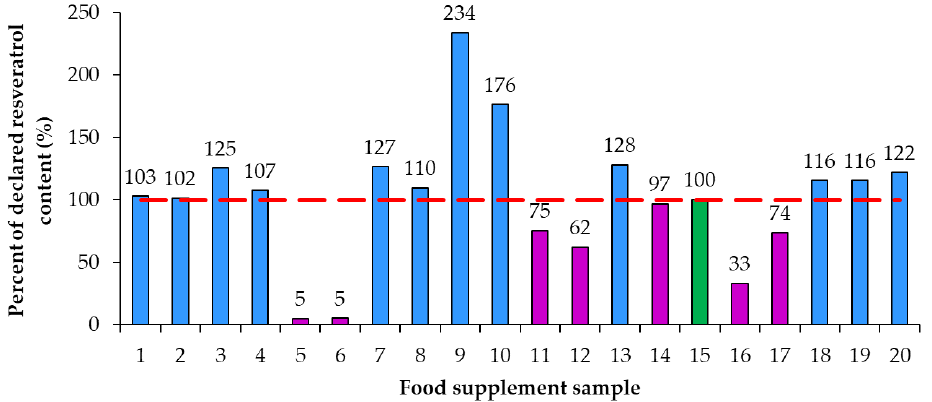
Figure 5. Percent of declared resveratrol content in food supplements.